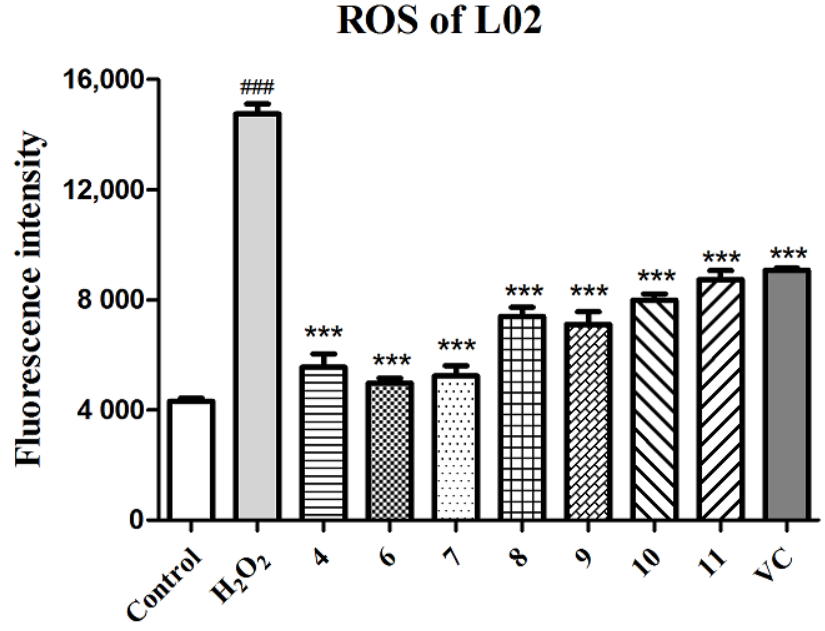
Table 4. Hepatoprotective effects of compounds 4 and 6 – 11 against H 2 O 2 -induced oxidative injury in L02 cells. a